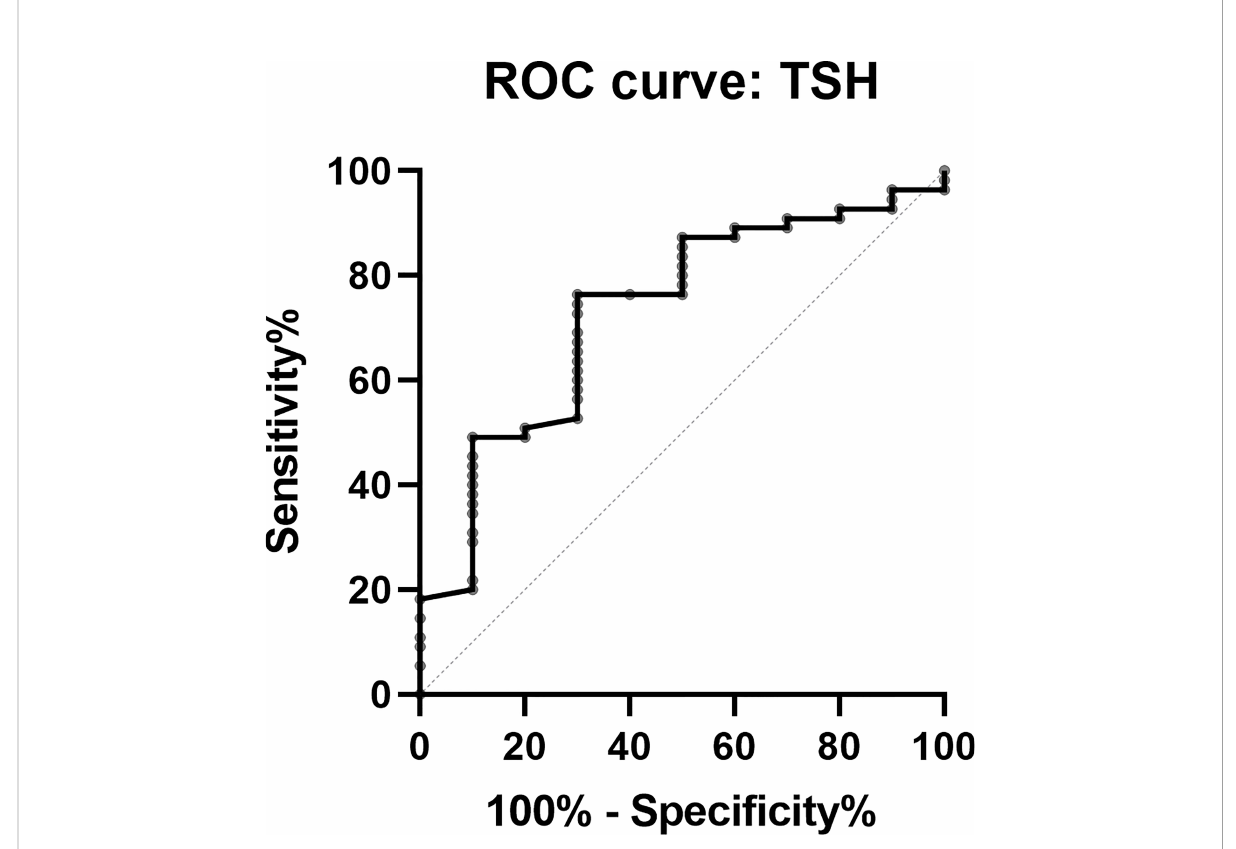
FIGURE 4 Receiver operating characteristic curve of postsurgical TSH in predicting CR